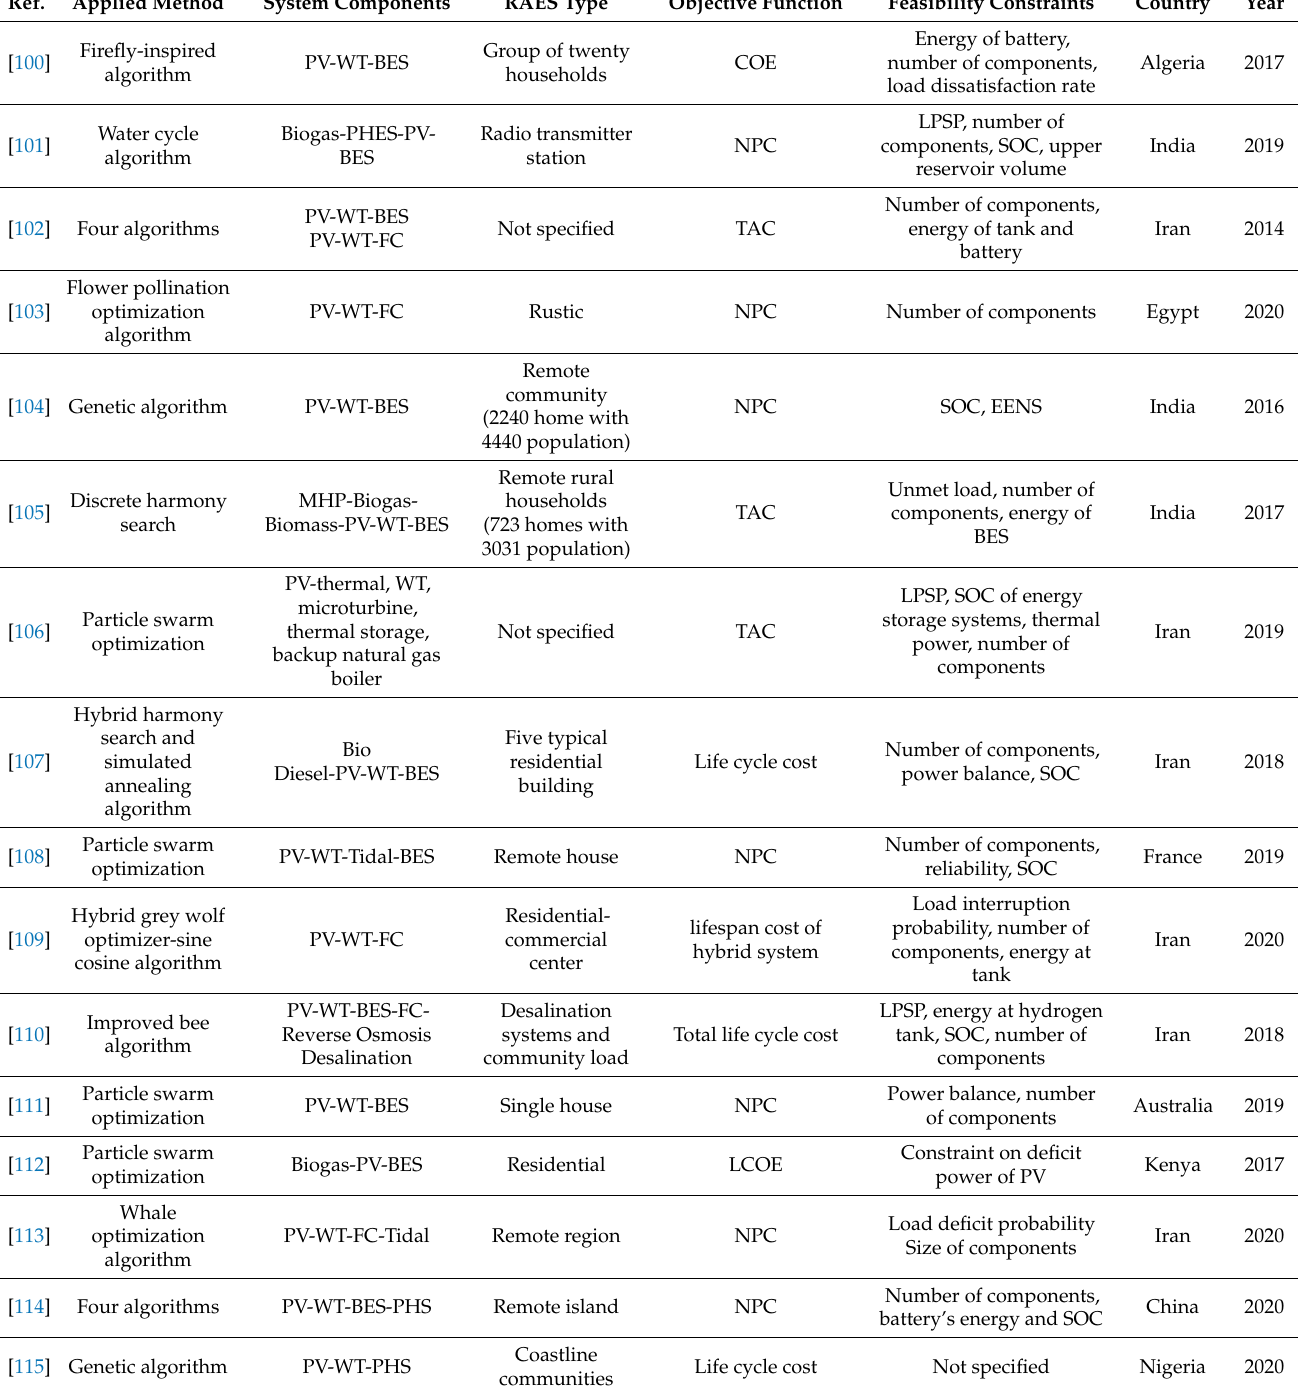
Table 7. Single-objective metaheuristic capacity optimization for clean RAES systems.